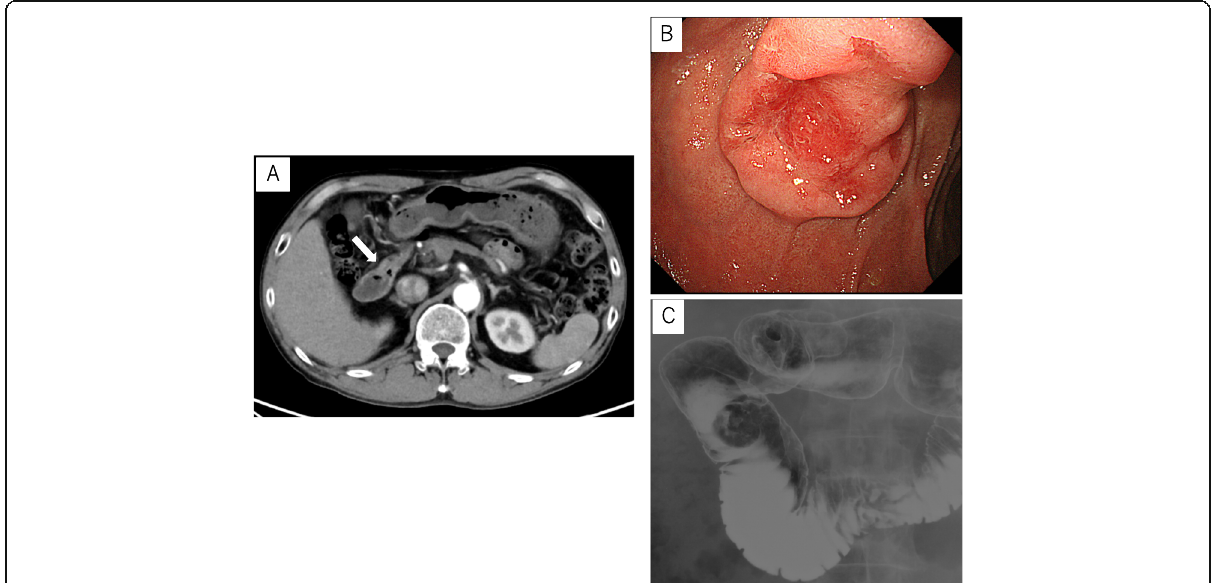
Fig. 1 a An enhanced computed tomography revealed the thickened wall of the duodenum without invasion outside the wall, nor lymph node swelling (arrow). b Gastrointestinal endoscopy showed a type 2 tumor, measuring about 25 mm in diameter at the second portion of the duodenum. c An upper gastrointestinal image revealed a clearly demarcated filling defect in the second portion of the duodenum